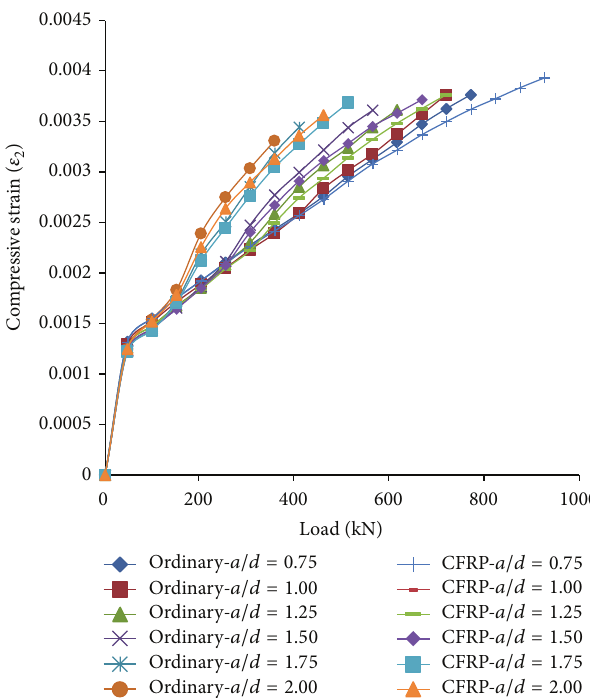
Figure 8: Load-compressive strain curve of unstrengthened and CFRP-strengthened RC